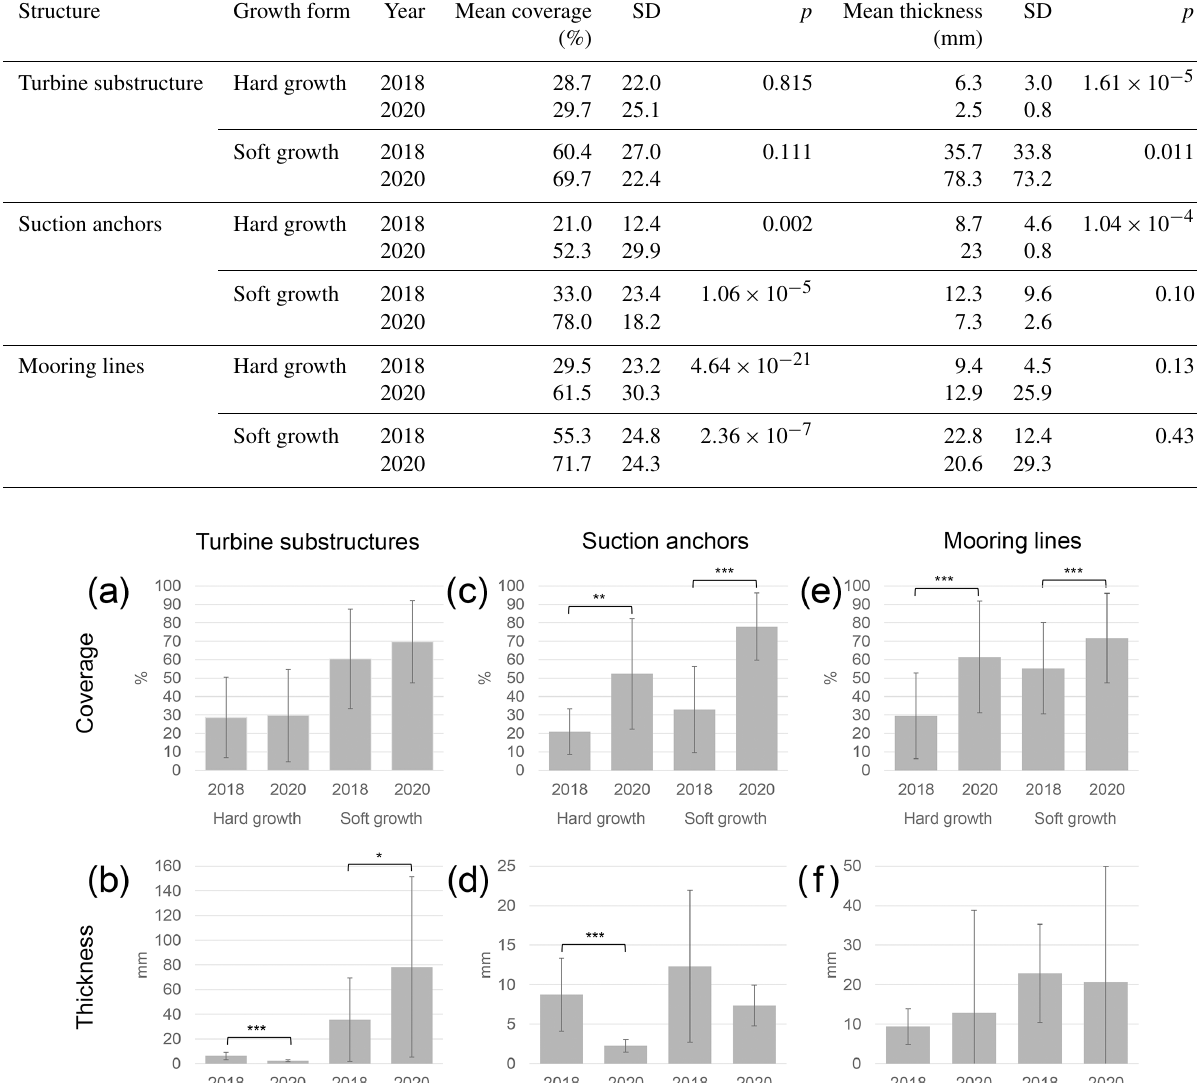
Table 2. Comparison of mean coverage and thickness of epifouling growth on turbine substructures, suction anchors and mooring lines between 2018 and 2020. Structure Growth form Turbine substructure